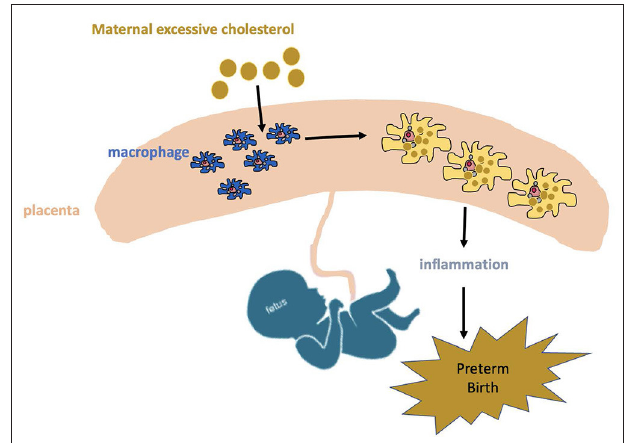
FIGURE 1 | Potential mechanism of maternal hypercholesterolemia contributing to preterm birth. Excessive cholesterol from mother with hypercholesterolemia will be transported into placenta and accumulates in macrophages, which will increase inflammation response and consequently trigger preterm